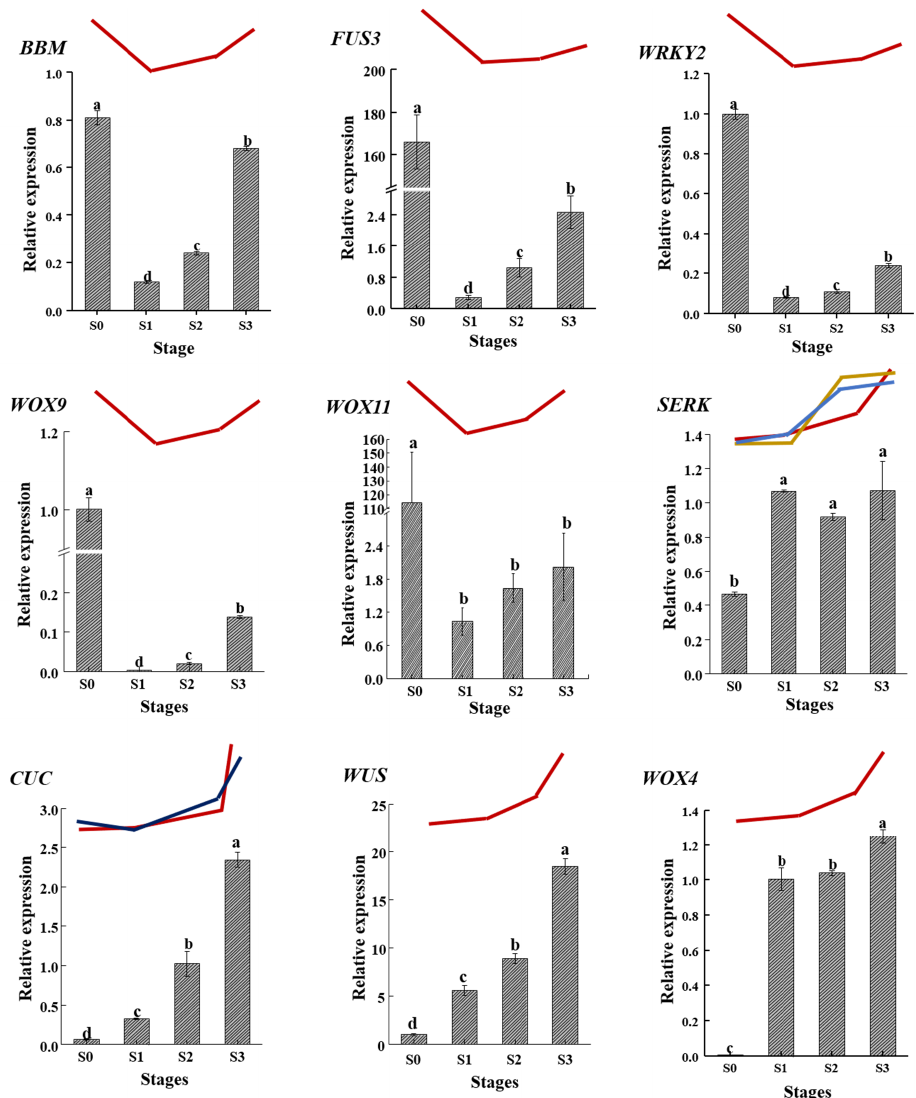
Figure 8. Validation of the expression of nine important candidate DEGs by qRT-PCR. Different lowercase letters indicate significant differences among different stages (Duncan’s test at p < 0.05 after analysis of variance). The broken line represents the expression patterns detected by transcriptome analysis. There were three SERKs and two CUC detected by transcriptome analysis. The patterns of expression were shown in different colors.